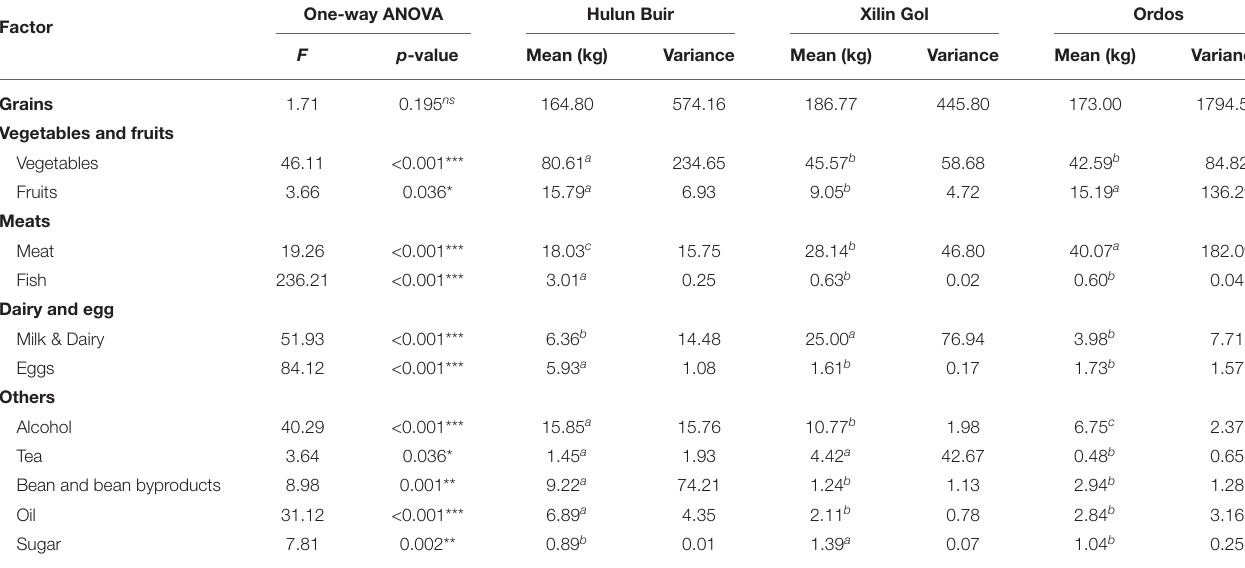
TABLE 5 | Quantities of annual food types consumed by rural residents at all three study sites and one-way ANOVA test results. One-way ANOVA Hulun Buir Xilin Gol Ordos Factor F p -value Mean (kg) Variance Mean (kg) Variance Mean (kg) Variance Grains